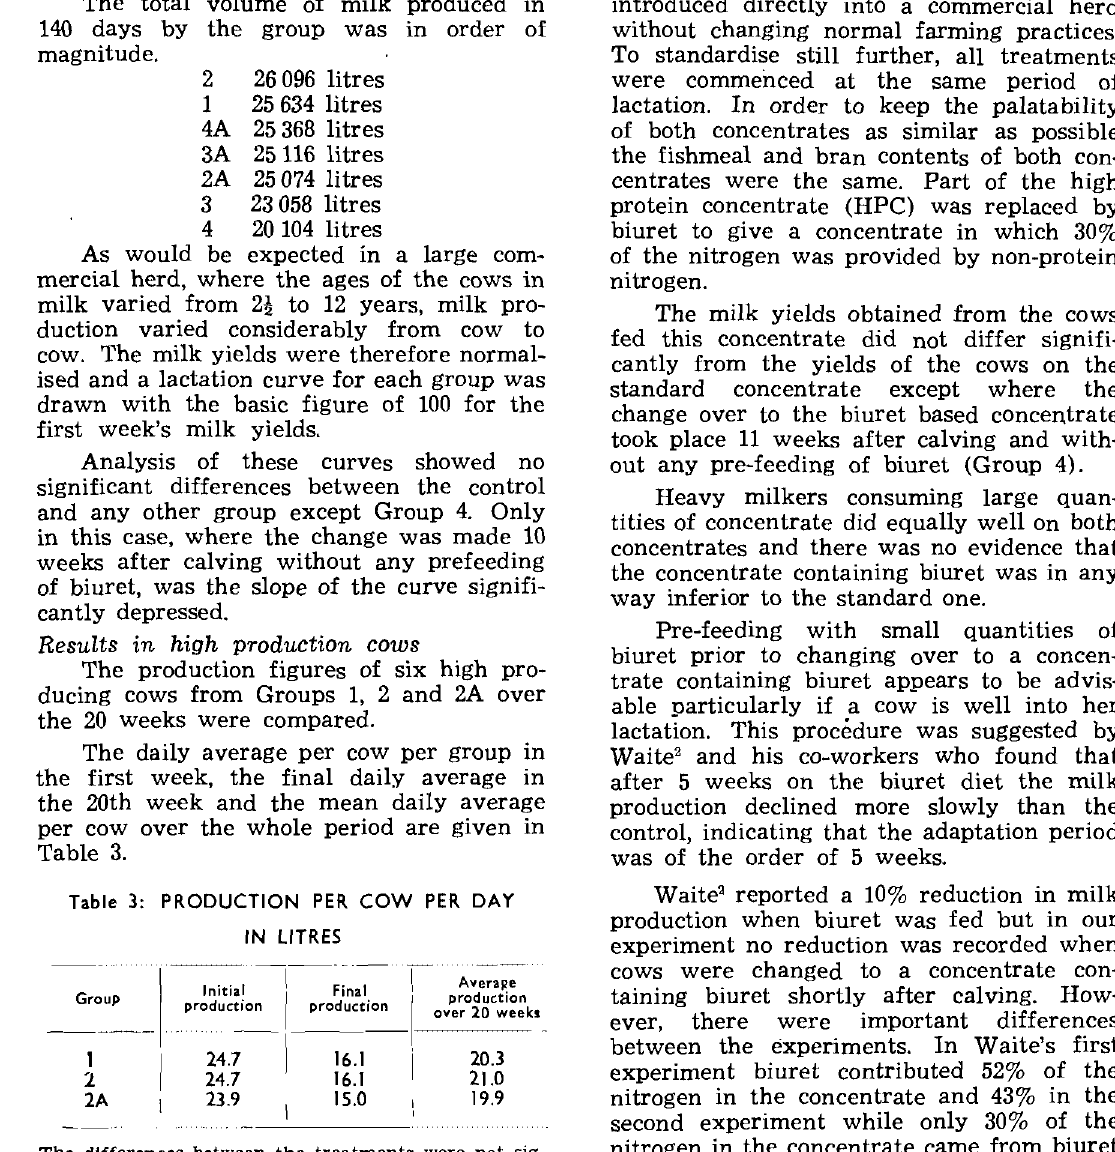
Table 3: PRODUCTION PER COW PER